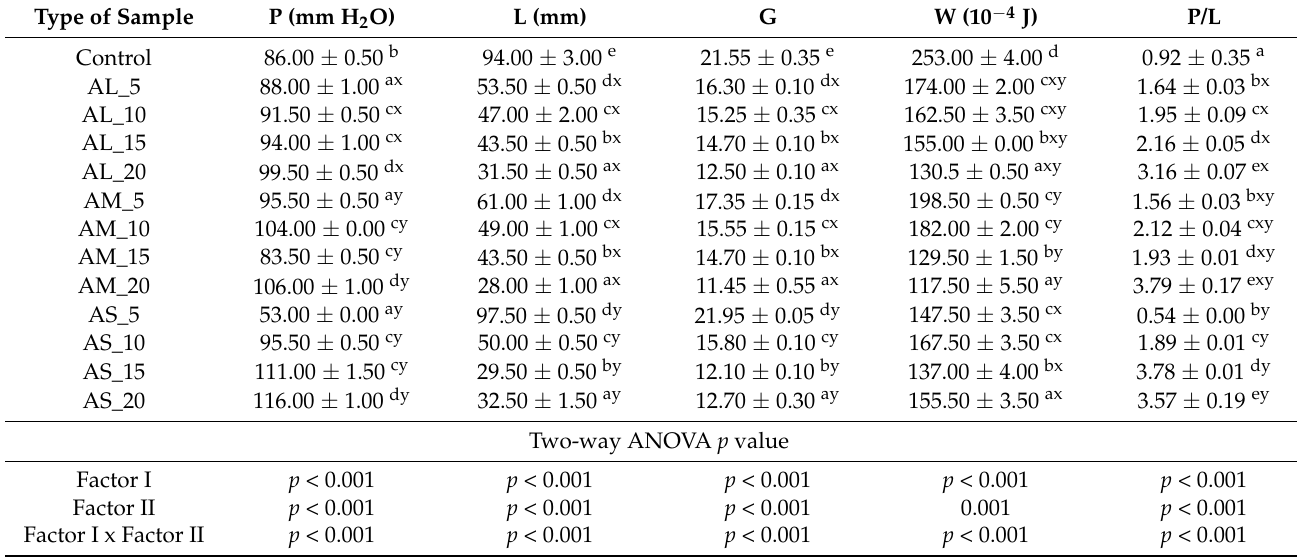
Table 3. Alveograph rheological properties as affected by amaranth flour of large (AL), medium (AM), and small (AS) particle sizes added at 5%, 10%, 15%, and 20% compared with the